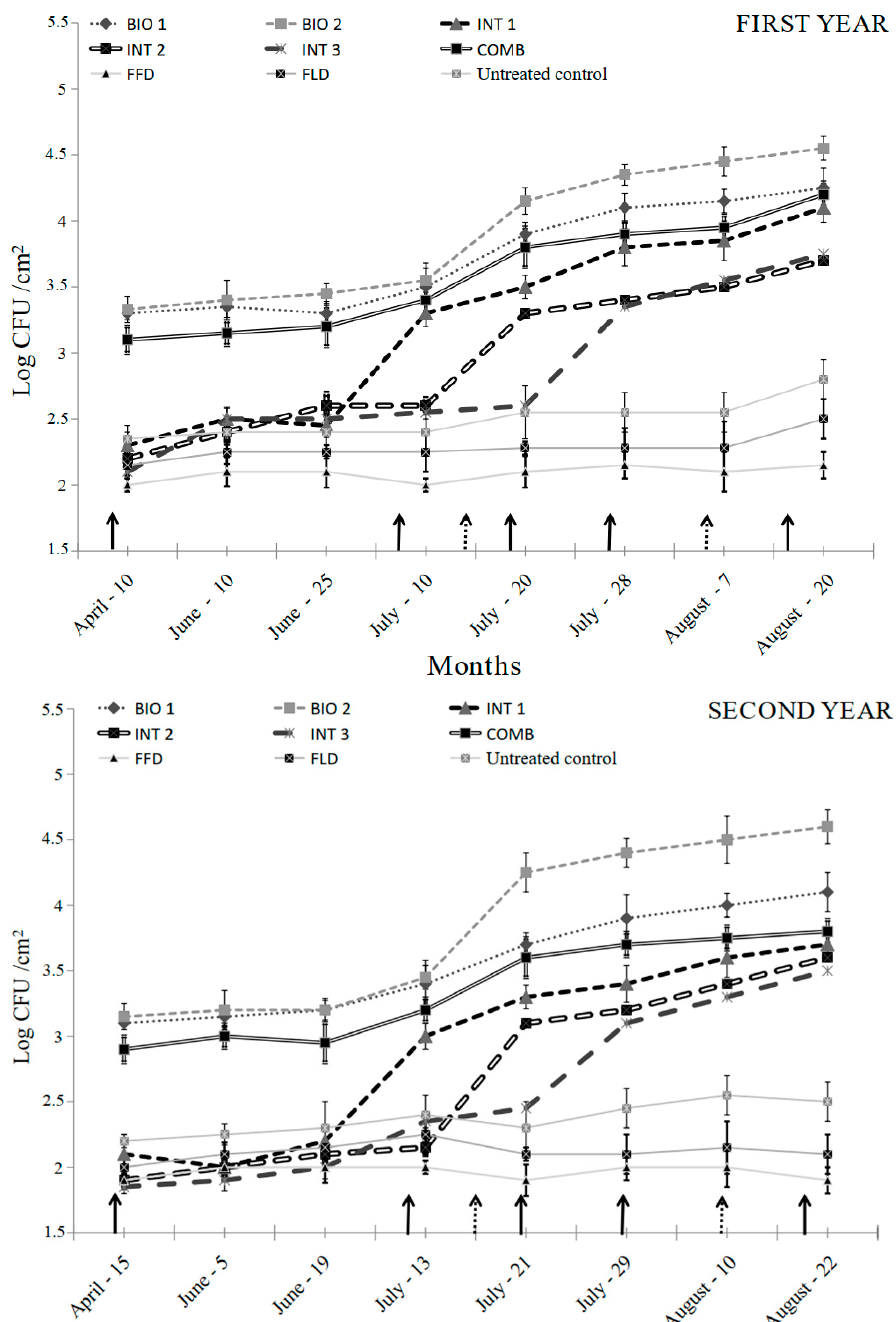
Figure 1. Dynamics of the total white yeasts population on plum fruits surface in field subjected to six different disease management strategies for two consecutive years: Biological, where the BCAs (the yeast Papiliotrema terrestris PT22AV or the commercial biofungicide Serenade Max ® based on Bacillus subtilis strain QST 713), were applied alone in five (BIO1) or seven (BIO2) consecutive treatments; Integrated, i.e., INT1, INT2 and INT3, consisted of the application from the beginning of the growing season of one, two or three treatments respectively, with the chemical fungicides boscalid or cyprodinil applied alternately, and each strategy was followed by BCAs applications until fruit harvest; Combined (COMB), in which the biocontrol yeast PT22AV or Serenade Max ® were applied in combination with a low dose (25% of the full label dose) of the synthetic fungicides Cantus ® or Chorus ® (alternately) in all treatments; Chemical, in which the chemical fungicides Cantus ® and Chorus ® were alternately applied at low (25% of full dose) (FLD) or at full label dose (FFD) in all treatments. The arrows indicate the time of treatments. Bars represent the standard deviation from the mean.